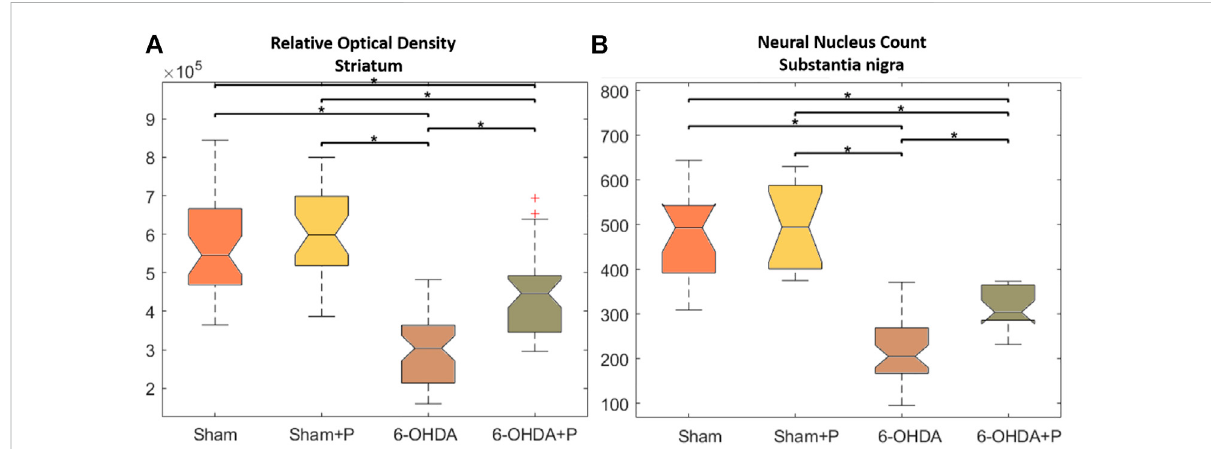
FIGURE 4 Statistical results of the Kruskall-Wallis and post hoc Bonferroni for TH immunohistochemistry analysis. (A) Optical density of the TH-positive fi bersinthestriatum;medianandcon fi denceintervalwereasfollows:5.458×10+5±2.5694×10+4(sham);5.984×10+5±2.862×10+4(sham + P); 4.466 × 10 + 5 ± 1.908 × 10 + 4 (6-OHDA + P); 3.04 × 10 + 5 ± 1.451 × 10 + 4 (6-OHDA). (B) TH-positive neuronal nuclei in the substantia nigra pars compacta; median and con fi dence interval were as follows: 493 ± 54 (sham); 494 ± 78 (sham + P); 205 ± 26 (6-OHDA + P); 304 ± 25 (6- OHDA).